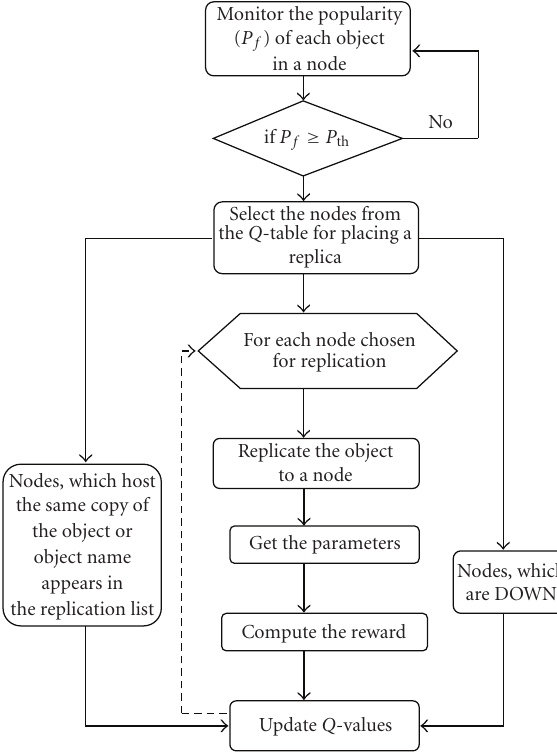
Figure 3: Set of actions taken by a node for replicating an object.